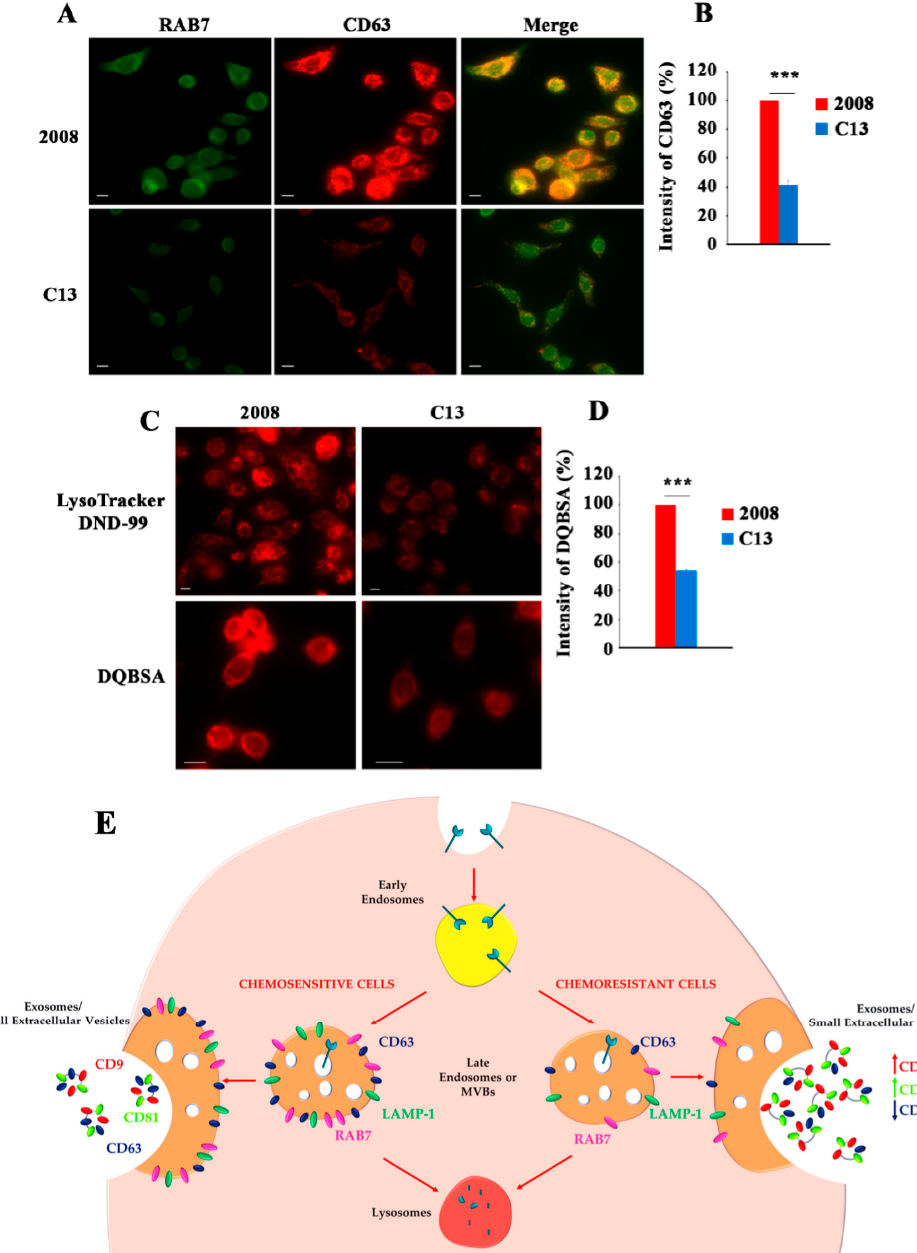
Figure 3. RAB7 regulates extracellular vesicle secretion in cisplatin resistant cells. ( A ) 2008 and C13 cervical cancer cells were immunostained with anti-RAB7 (green) and anti-CD63 antibodies (red) Scale bar: 10 μ m. ( B ) Immunofluorescence intensity of CD63 was quantified by ImageJ software. ( C ) Cells were labeled live with Lysotracker Red DND-99 (red) or incubated in the presence of DQ-Red BSA as indicated. Scale bar: 10 μ m ( D ) Fluorescence intensity of DQ-Red BSA was quantified by ImageJ software (Version 1.5Oi, Bethesda, MD, USA). Data represent the mean ± standard error of at least three independent experiments (*** p ≤ 0.001). ( E ) Intraluminal vesicles (ILVs) of multivesicular bodies (MVBs) and late endosomes are precursors of exosomes / small extracellular vesicles (sEVs). ILVs are generated by the inward budding of discrete domains of the membrane of early endosomes, which subsequently mature into MVBs and late endosomes. MVBs can be directed to lysosomes or to plasma membrane (PM). Fusion of MVBs with PM determines exosomes / sEVs release in the extracellular space. RAB7, LAMP-1 and CD63 are localized onto late endosomes / MVBs and they are downregulated in chemoresistant cells. RAB7 downregulation causes chemoresistance by increasing release of CD9- and CD81-positive exosomes. MVBs, Multivesicular